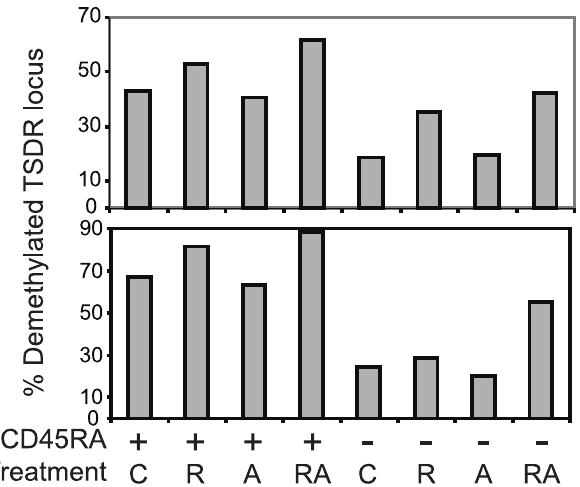
Figure 6. Status of the Treg-specific demethylated region (TSDR) predicts functional activity. Prior to setting up the suppression assays displayed in Fig 5, 1 million expanded T cells were harvested, genomic DNA was prepared, and methylation status of TSDR was determined as described in the Material and Methods. The percentage of demethlyated CpG residues from two donors is displayed. R, A, and RA refers to Tregs expanded in RAPA, ATRA or RAPA and ATRA